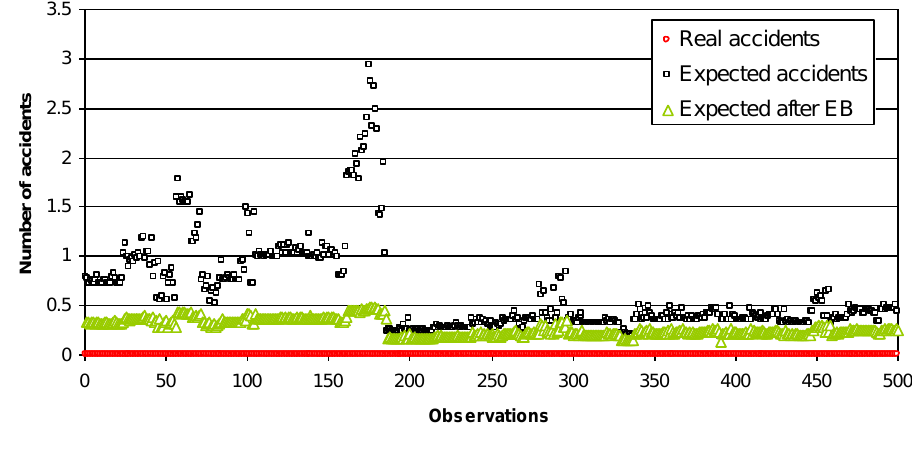
Figure 2. Expected number of accidents comparing real number of accidents and predicted number after applying EB method (road section of 500 m)—observation 0 until